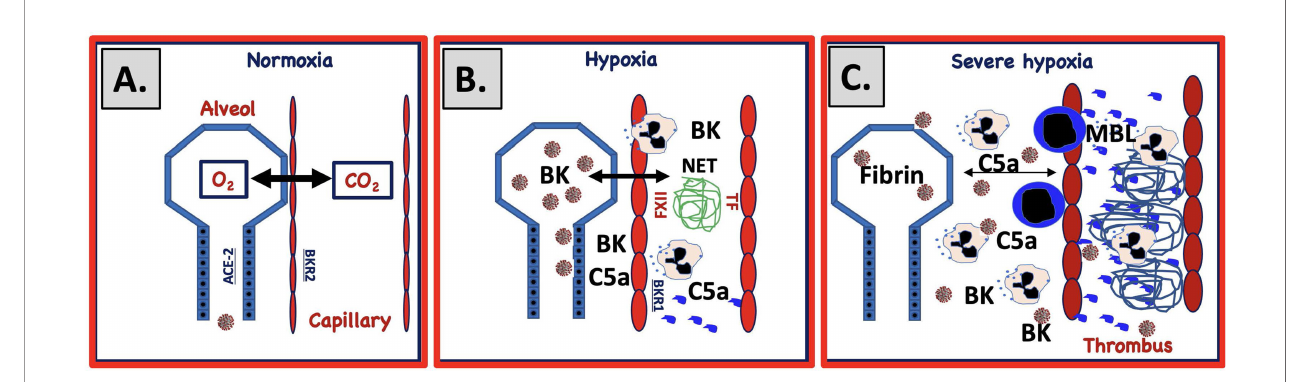
FIGURE 2 | Proposed mechanism for IIIS involvement in SARS-CoV-2-induced ARDS. (A) Under normal circumstances gas is exchanged over a narrow gap between alveolar epithelial cells (blue) and capillary endothelial cells (red). SARS-CoV-2 infects the alveolar/bronchial epithelial cells via ACE-2. Bronchial epithelial cells express ACE-2 and endothelial cells bradykinin receptor 2 (BKR2). Infection of alveolar epithelial cells activates the complement and KK systems and generates C5a and bradykinin (BK). (B) C5a and BK activate endothelial cells and elicit increased vascular permeability, which widens the gap between the cell linings. Activated endothelial cells also trigger complement and KK systems activation that upregulates BKR1, further increasing vascular permeability, damaging cells and inducing necrosis and apoptosis. BK and C5a elicit chemotaxis of PMNs that release neutrophil extracellular traps (NETs, depicted as a blue mesh). (C) Activated endothelial cells (TF) and NETs (TF and FXIIa) trigger coagulation activation and thrombus formation and further ampli fi e KK and complement activation. Plasma proteins leak into the alveolae causing fi brin precipitation. Invasion of PMNs and monocytes further increases the gap between the cell linings, ultimately leading to a collapsed exchange of gases over the epithelial and endothelial